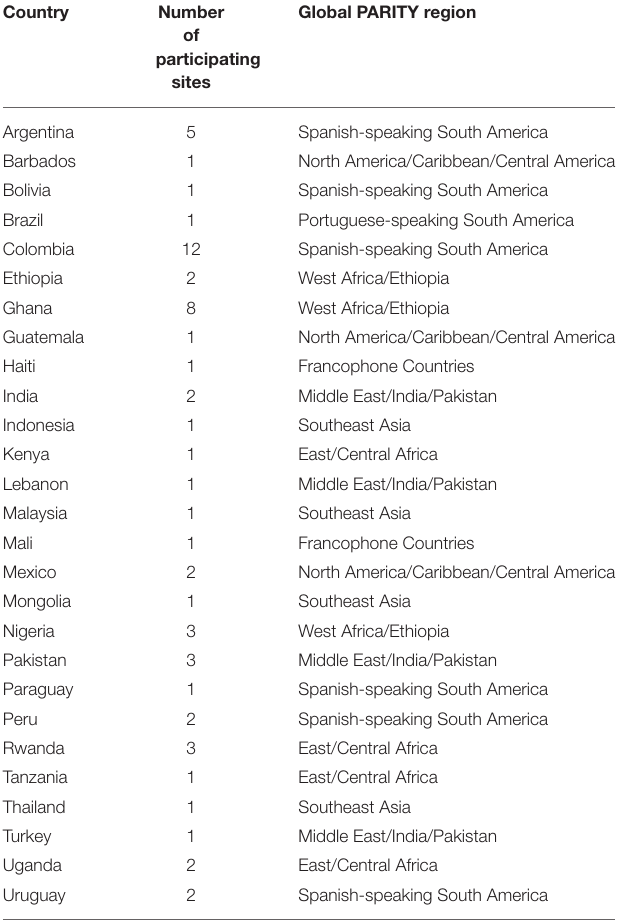
TABLE 1 | Participating sites by country and global PARITY-designated region.